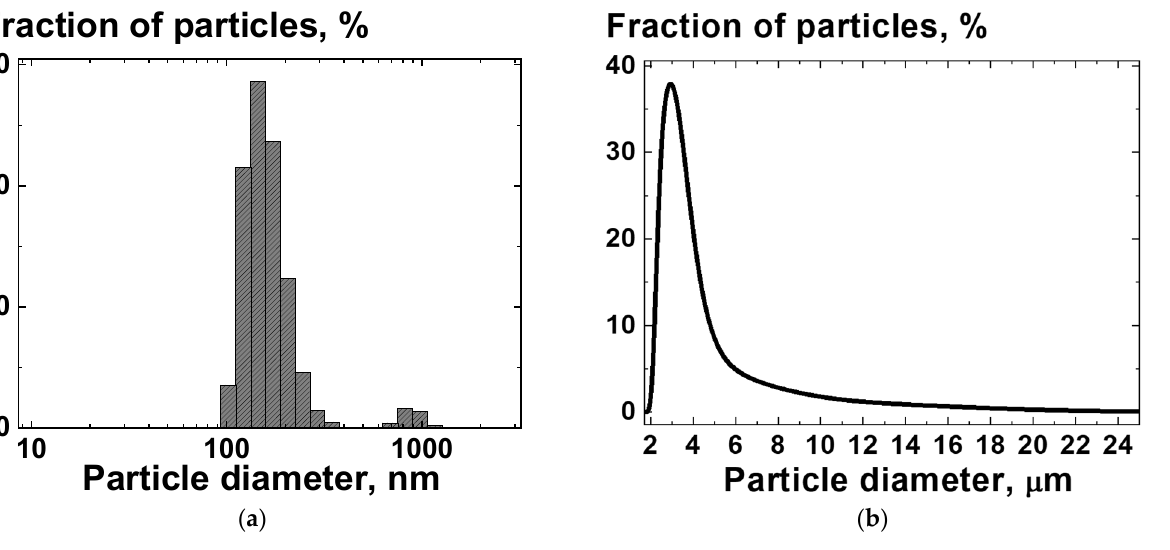
Figure 2. Distribution of diameter of the NDS particles in a suspension of NDS powder in acetone, obtained with ( a ) DLS and ( b ) LD methods.